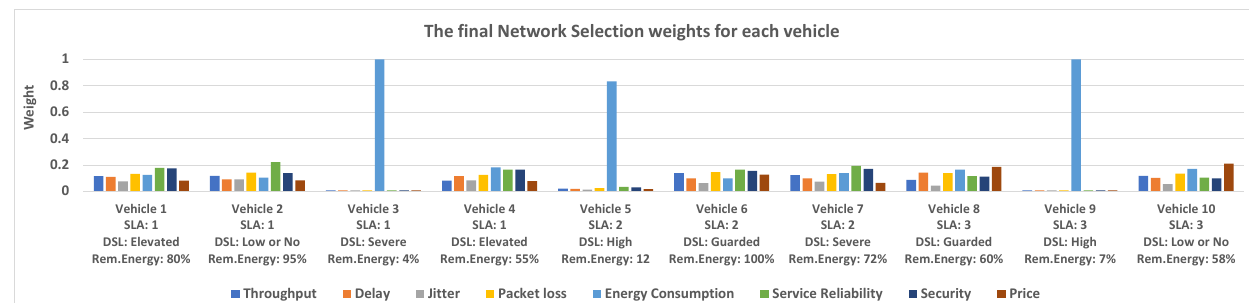
Figure 20. The final network selection weights for each